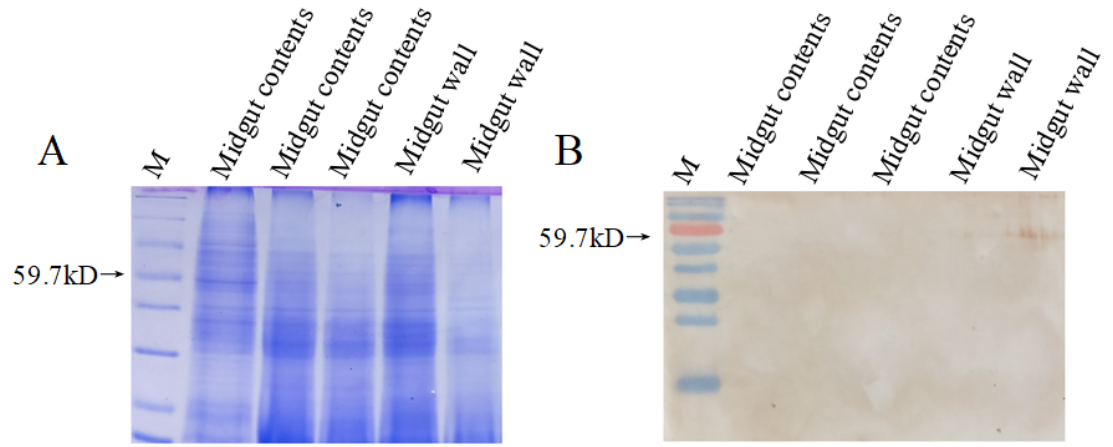
Figure 9. SDS-PAGE and Western blot analysis of cotton bollworm midgut wall and midgut contents. ( A ) SDS-PAGE analysis of cotton bollworm midgut wall and midgut contents; ( B ) Detection of cotton bollworm midgut wall and midgut contents in vitro by Western blot analysis using anti-sulfatase antiserum. M: Protein marker.